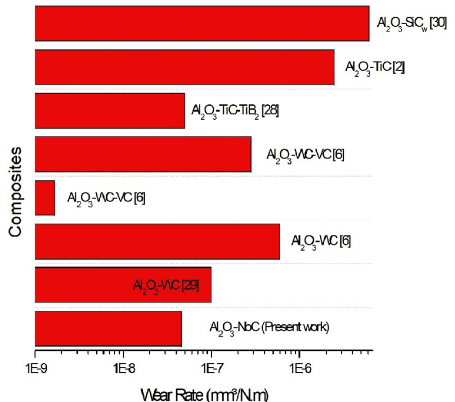
O composites reinforced with NbC and 2 3